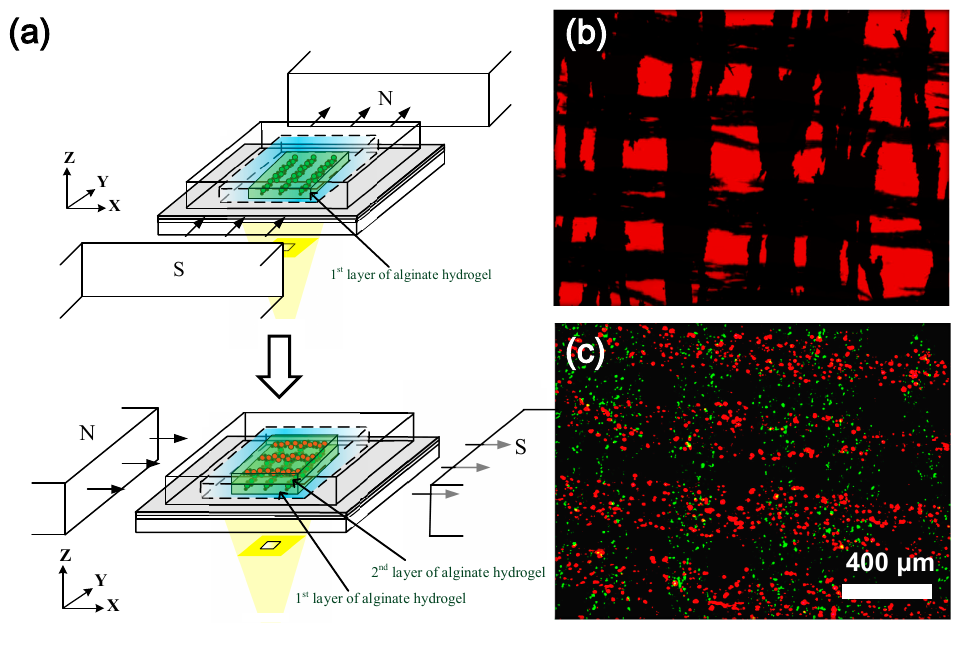
Figure 6. ( a ) Schematic diagrams of performing multiplexed micropatterning and adjusting orientation of the magnetic fields for formation of two layers of the cell-encapsulated alginate hydrogels, where cells in each layer can be manipulated into cross-directional arrangements. ( b ) The optical and ( c ) merged fluorescent images of the magnetically-labeled BHK-21 cells encapsulated in the two layers of rectangular alginate hydrogels. Cells with green fluorescence in the first layer; cells with red fluorescence in the second